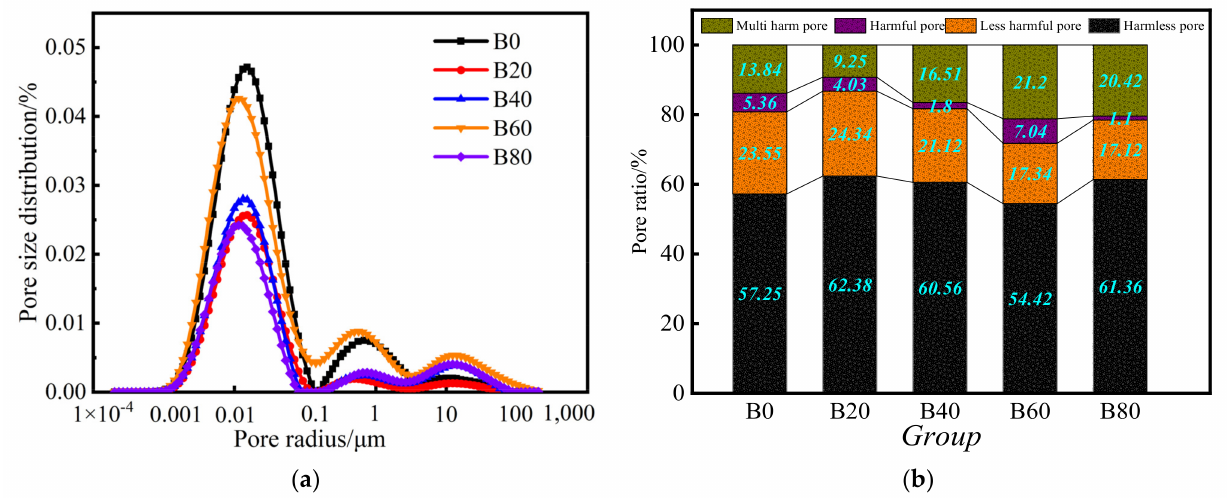
Figure 11. Pore size distribution and pore space distribution as a percentage: ( a ) pore size distribution; ( b ) pore space distribution as a